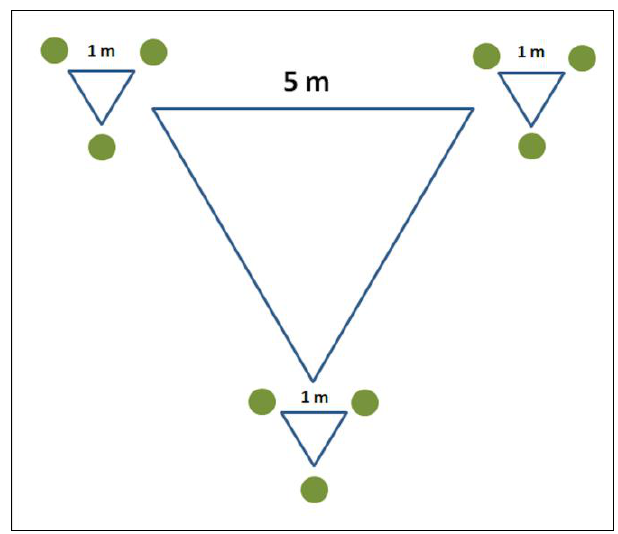
Figure 2. Scheme of sod transplants.